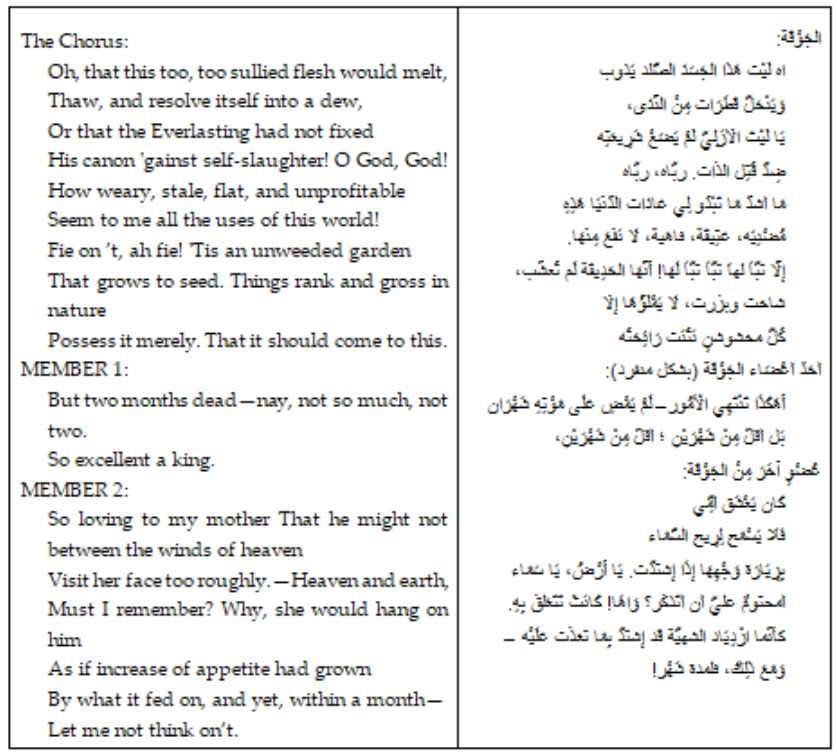
Figure 3. Shakespeare’s text and the Arabic translation of the speech ‘O That This Too Solid Flesh Would Melt’, which is spoken by the Hamlet Chorus in Act I Scene 2. The text is transcribed from a video of the production posted on YouTube (See El-Basha 2013).